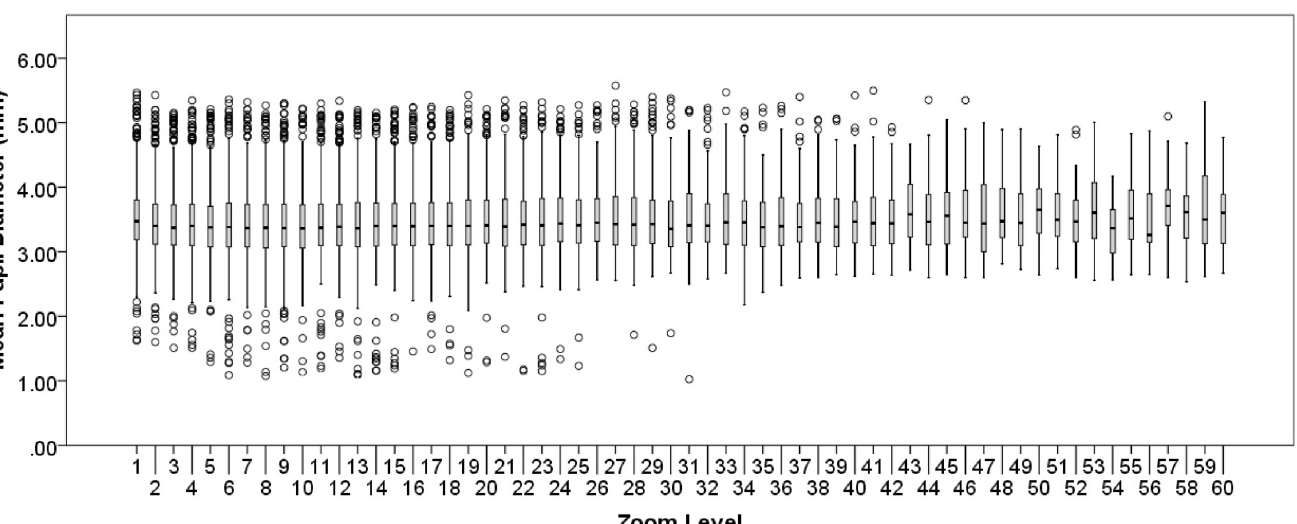
PLOS ONE | https://doi.org/10.1371/journal.pone.0282616 March 9,